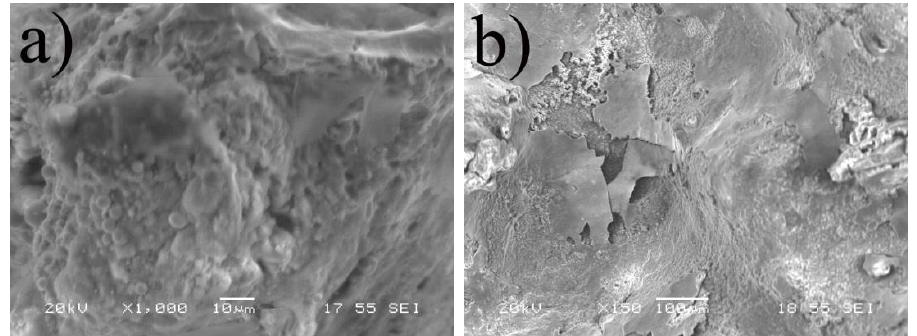
Figure 6. Photograph of surface on central crack by SEM (( a ) enlarged fracture surfaces of the cracks; ( b ) fracture surface morphology of cracks).